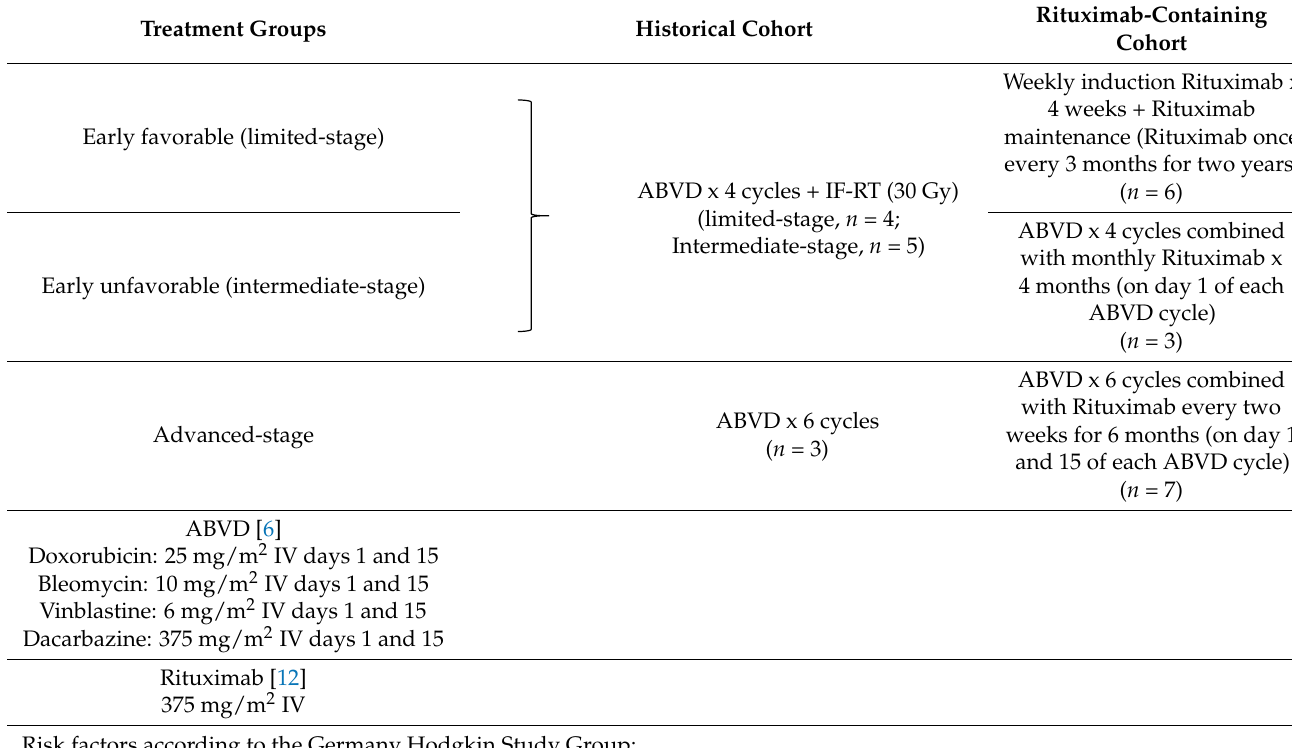
Table 2. Risk-adapted strategies for historical cohort and Rituximab-containing cohort. Treatment Groups